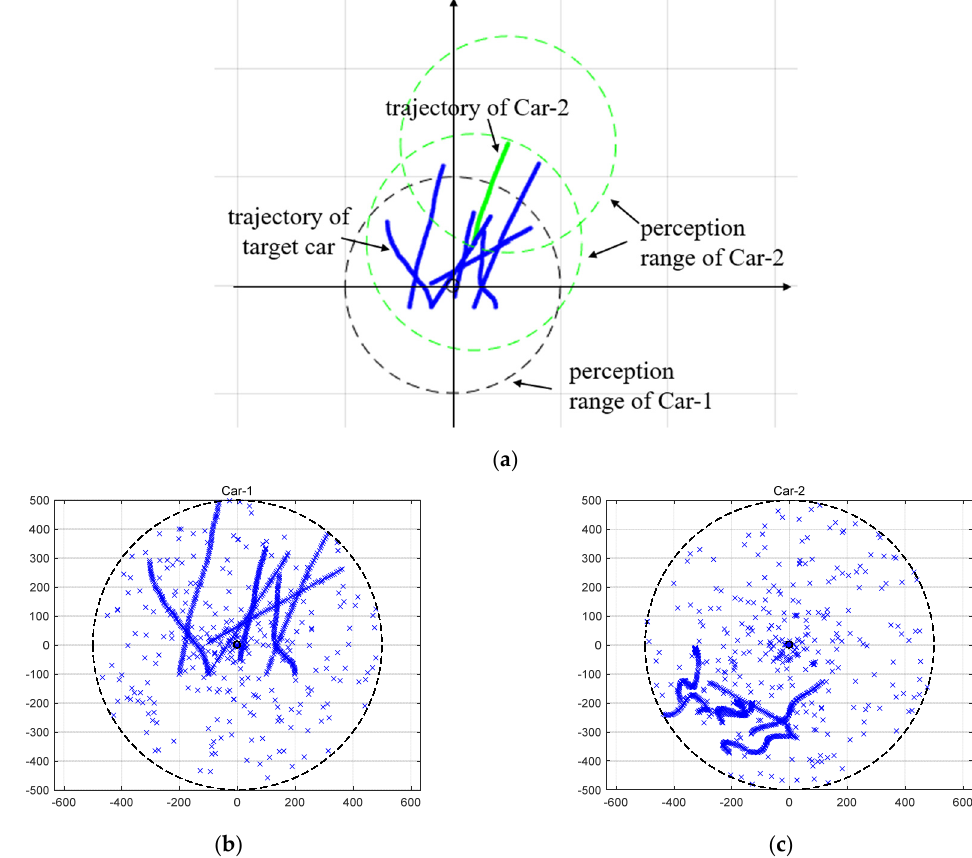
Figure 3. ( a ) Trajectories of target vehicles and Car ‐ 2 in the coordinate system of Car ‐ 1; ( b ) Measurements perceived by Car ‐ 1; and ( c ) Measurements perceived by Car ‐ 2.